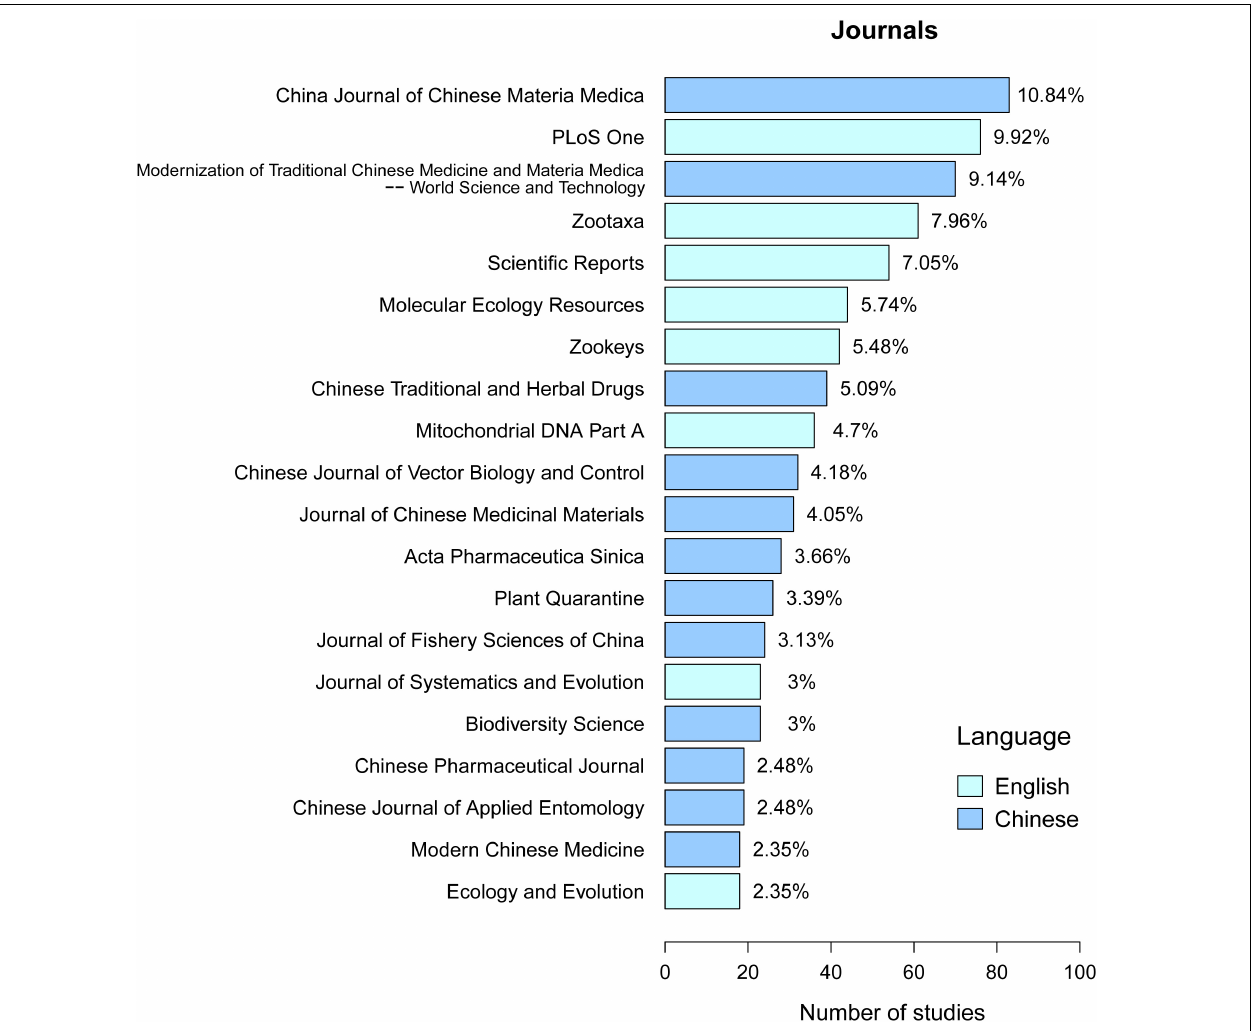
FIGURE 6 | Top 20 journals that published DNA barcoding studies contributed by Chinese scientists. The X axis represents the number of studies, and the Y axis represents journal names. Percentages represent the number of articles published by each journal as a percentage of the total number of the top 20